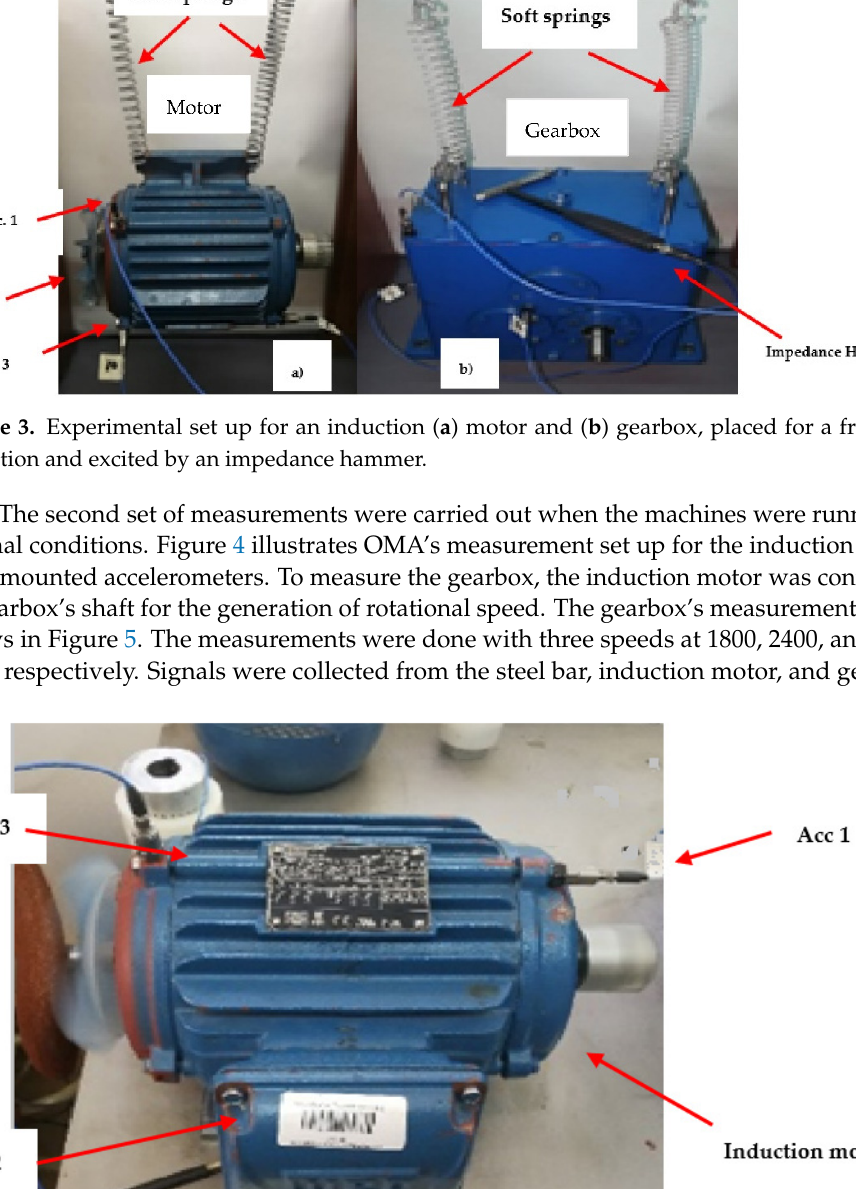
Figure 5. OMA’s measurement set up for the gearbox with mounted accelerometers. Figure 6 illustrates the typical measured signals from the force impedance hammer and vibration response in the time-domain. Figure 6. Force and vibration signals in the time-domain: ( a ) the impedance hammer’s force; ( b ) vibration response.